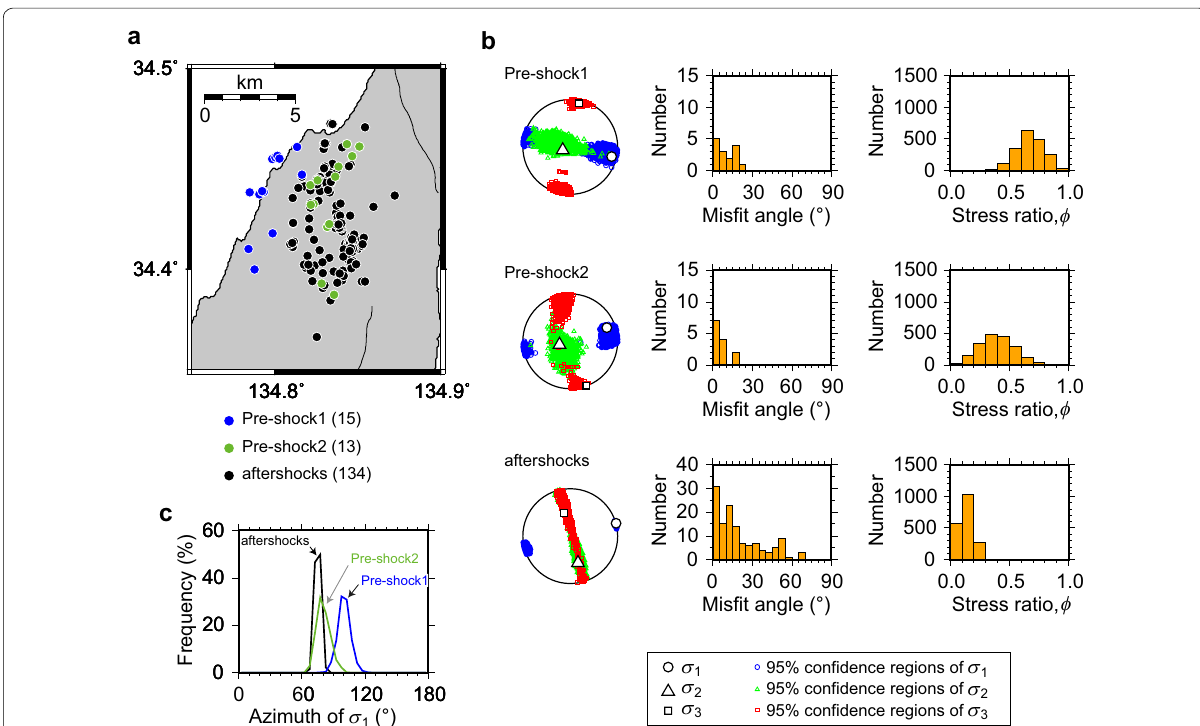
Fig. 8 Results of stress tensor inversion. a Earthquake distribution of each dataset used in stress tensor inversion. The number within each dataset of parentheses indicates the number of events used for the inversion. b Results of stress tensor inversion for each dataset. The left-hand panels show the principal stress axes with their 95% confidence regions plotted on the lower hemisphere stereonets. The middle panels show the misfit angle for the data with respect to the optimal stress tensor determined by the stress tensor inversion. Here, the misfit angle represents the angle between the tangential traction predicted by the optimal solution and the observed slip direction on each plane, as determined from the focal mechanism. The right-hand panels show the frequency of the stress ratio φ , which belongs to the 95% confidence region. c Frequency of the azimuth of σ 1 from the 95% confidence region of the stress tensor inversion. Here, 180° is subtracted from azimuth, if necessary, to ensure that all orientations can be plotted in the range of 0° to